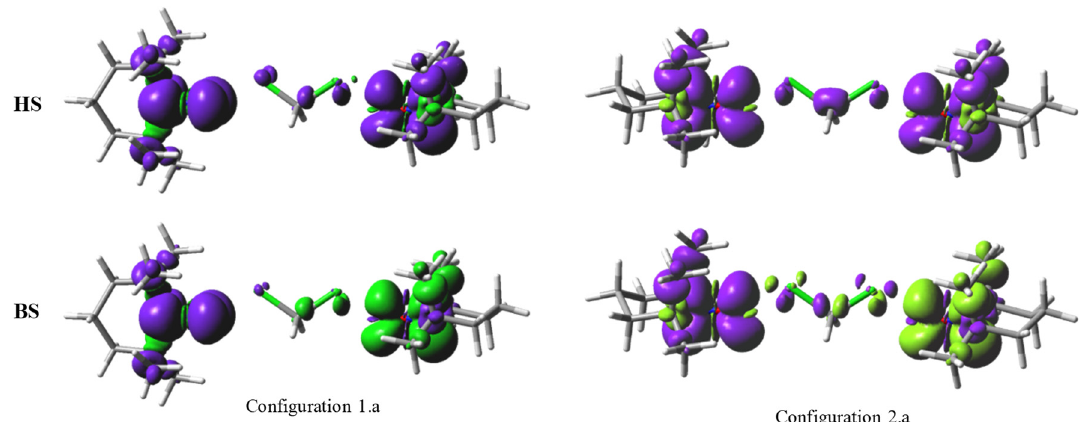
Figure 7. The spin density maps, as 0.001 e / Å 3 isosurfaces, for the 1.a and 2.a configurations, at the r = 7 Å separation between the oxygen atoms of the colinear NO groups, with the oxygen atoms in the vicinity of the chlorine atoms of the dichloromethane molecule. The upper part shows the predominant α density of the triplet configuration, labelled HS (High Spin). The lower half shows the Broken Symmetry (BS) configuration. The violet and green colours correspond to the respective α and β spin densities.